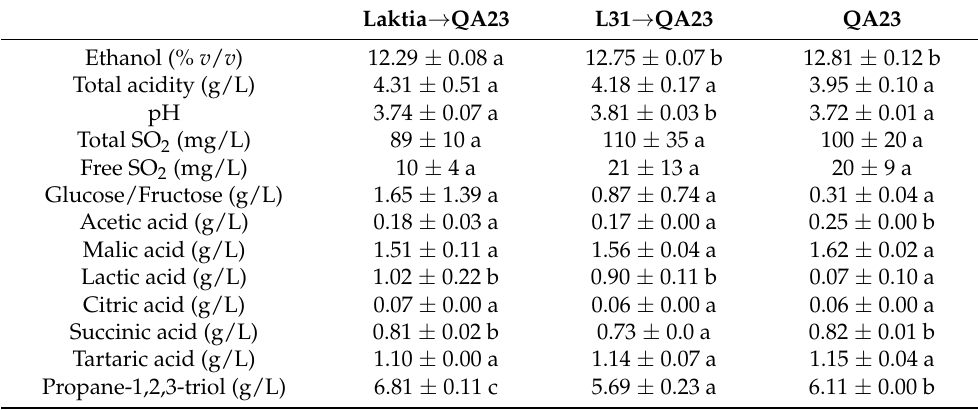
Table 1. Oenological parameters of the different yeasts on the last day of fermentation. Different letters in the same row indicate statistically significant differences according to the Student–Newman– Keuls (S–N–K) test. α =